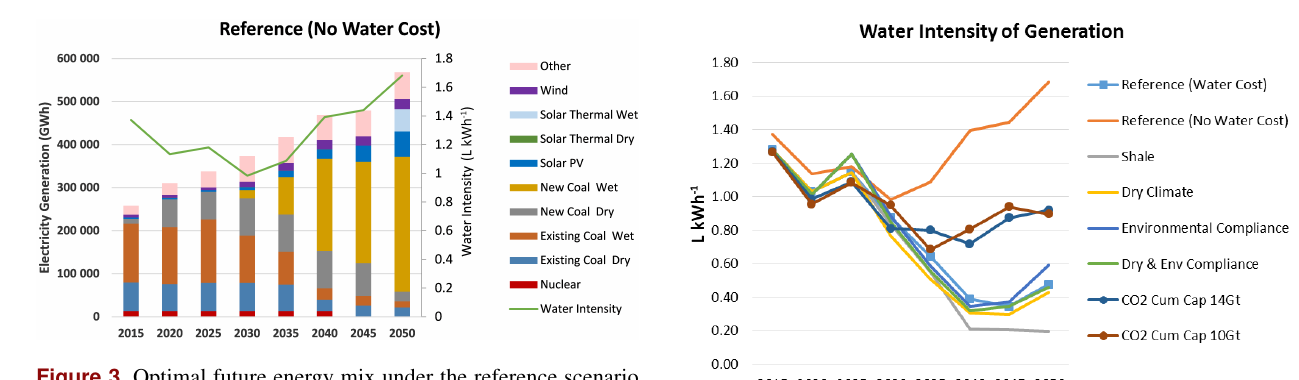
Figure 3. Optimal future energy mix under the reference scenario with no regional variability in water supply costs.